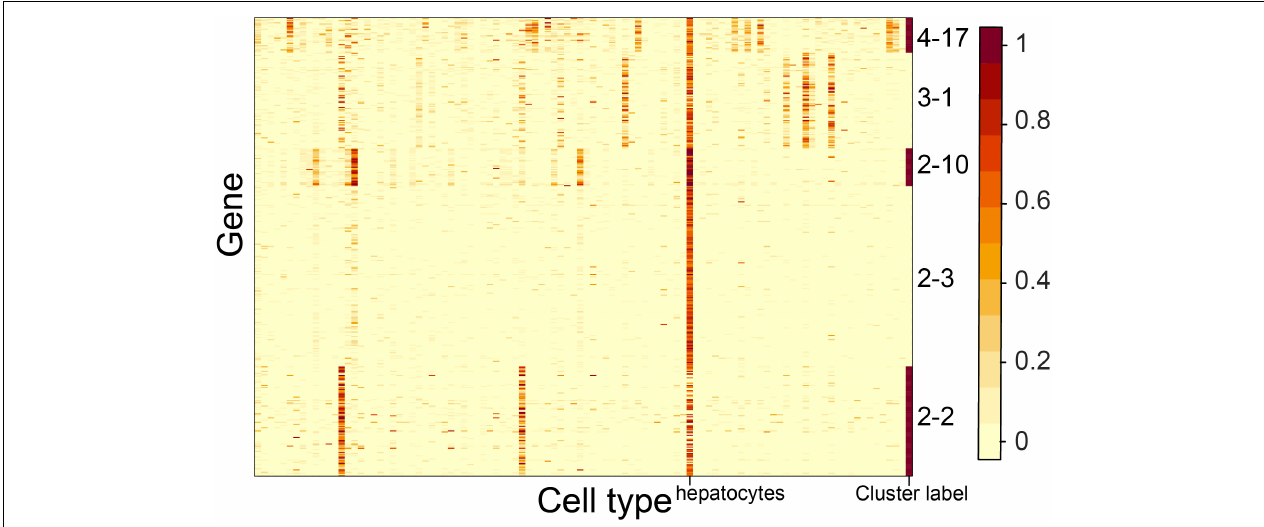
FIGURE 7 | Expression heatmap of the CTS gene clusters specifically expressed in hepatocytes. Genes in the heatmap were sorted by the gene clusters, and the “cluster label” distinguished the genes from different gene clusters.